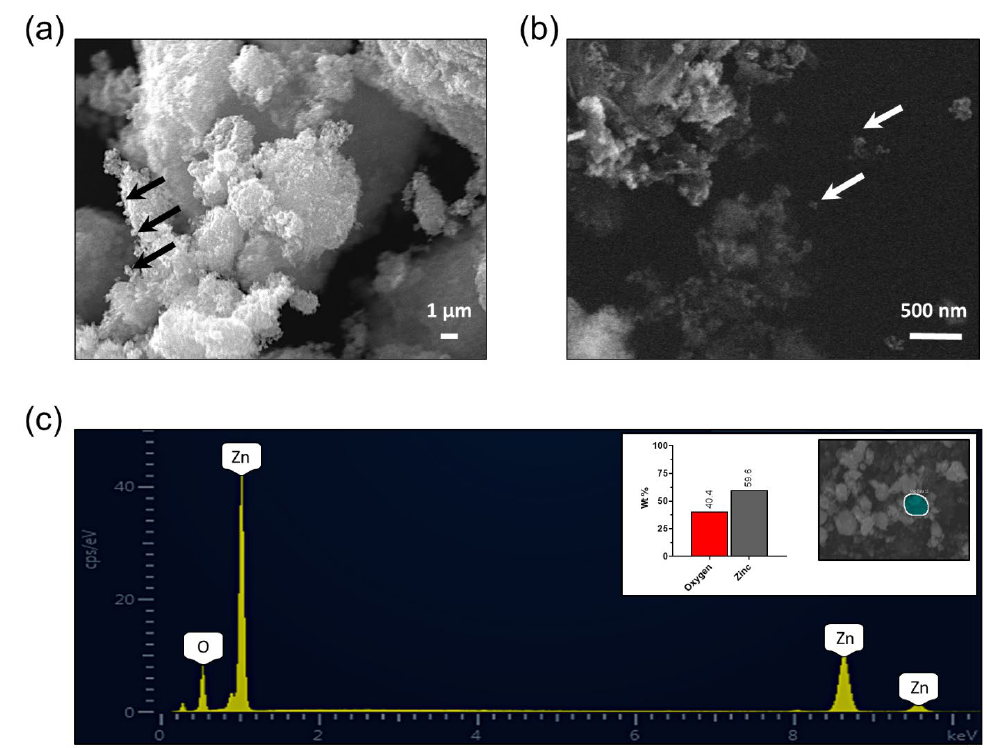
Figure 3. Scanning electron micrographs ( a ) and scanning transmission electron microscopy (STEM) ( b ) of ZnO NPs. Representative EDX spectrum and elemental mapping of ZnO NPs ( c ). The pHpzc value was obtained for ZnO NPs through the plot of initial pH values and final pH (Figure 4a). A value of 6.21 for ZnO NPs was determined. Other studies have reported higher pHpzc values. For example, Kataria and Garg [79] reported pHpzc values of 6.9. Meanwhile, Chauhan et al. [80] reported pHpzc values of 7.5. The differences ob- served with other studies may be a consequence of the method of synthesis, the aggrega- tion of the NPs, the presence of impurities, among other factors. The pHpzc corresponds to the pH in which the positive and negative charges are equal on the surface of an adsor- bent [81]. Therefore, the surface of ZnO NPs will be positively charged if pH < pHpzc, while it will have a net negative charge if pH > pHpzc. This parameter is important for the heavy metal adsorption process by ZnO NPs, since at values higher than pH = 6.21 the ZnO NPs surface will be negatively charged enhanced electrostatic attraction between heavy metal cations (such as Cu(II)) and ZnO surface. On the contrary, at lower pH values (<pHpzc) the adsorption process will not be as effective as there are higher repulsive forces. Even so, the adsorption process is not determined solely by this parameter, but will also depend on the surface area, the density of pores, the presence of competitors, among other factors. Conversely, the measurement of the zeta potential reveals that the pH where the surface potential of the material is zero, the isoelectric point (IEP) [82] (Figure 4b), is 10.2, a value higher than that obtained at the pH PZC . The values of pH PZC and IEP must be